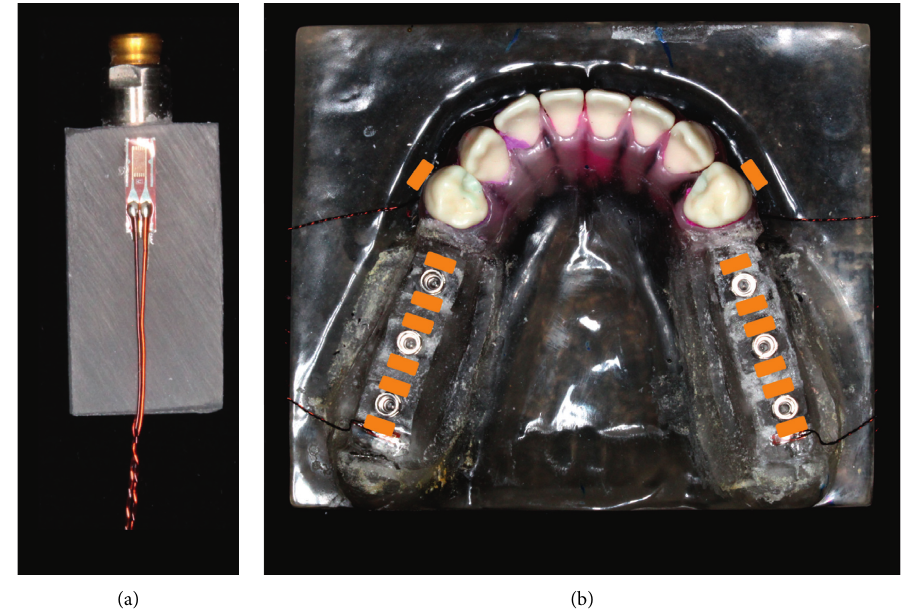
Figure 1: (a) Dental mini-implant attached to a strain gauge. (b) Model labeled with the locations of strain gauges.